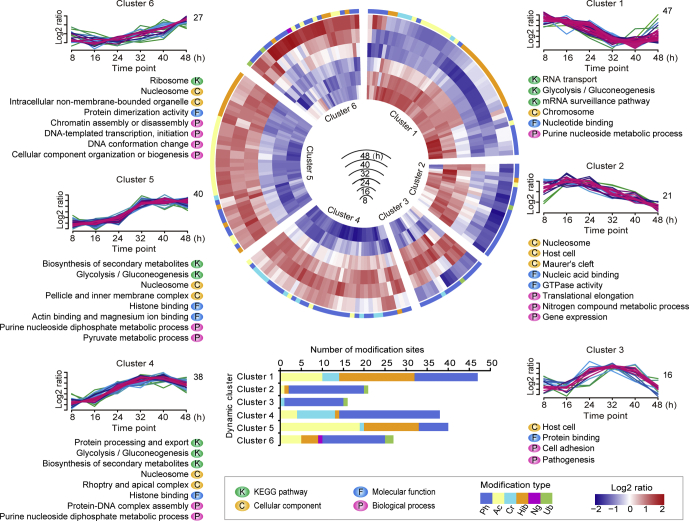
Dynamic cluster heatmap of modification sites with significant changes (189 modification sites, FDR < 0.01) of P. falciparum proteins during the IDC. The circular heatmap in the middle represents the abundance variation of each modification site over time from 8, 16, 24, 32, 40, and 48 h after invasion. The redder the color, the higher the abundance. The bluer the color, the lower the abundance. The six sections of the heatmap correspond to the six clusters based on the abundance trends of modification during the IDC, and the main function terms enriched in each cluster are displayed below the graphs. The function entries were enriched from KEGG pathways (represented by “K”) and GO terms, which were divided into three categories: cell components (represented by “C”), molecular function (represented by “F”), and biological process (represented by “P”). FDR, false discovery rate; GO, Gene Ontology; IDC, intraerythrocytic development cycle; KEGG, Kyoto Encyclopedia of Genes and Genomes.